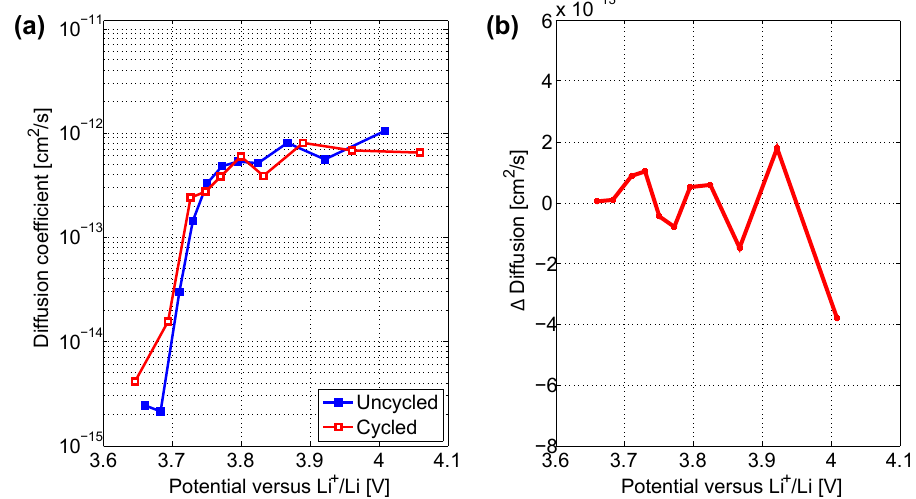
Figure 7. ( a ) Diffusion coefficient in uncycled and cycled positive electrodes determined by GITT characterisation. ( b ) Difference between cycled and uncycled electrodes.